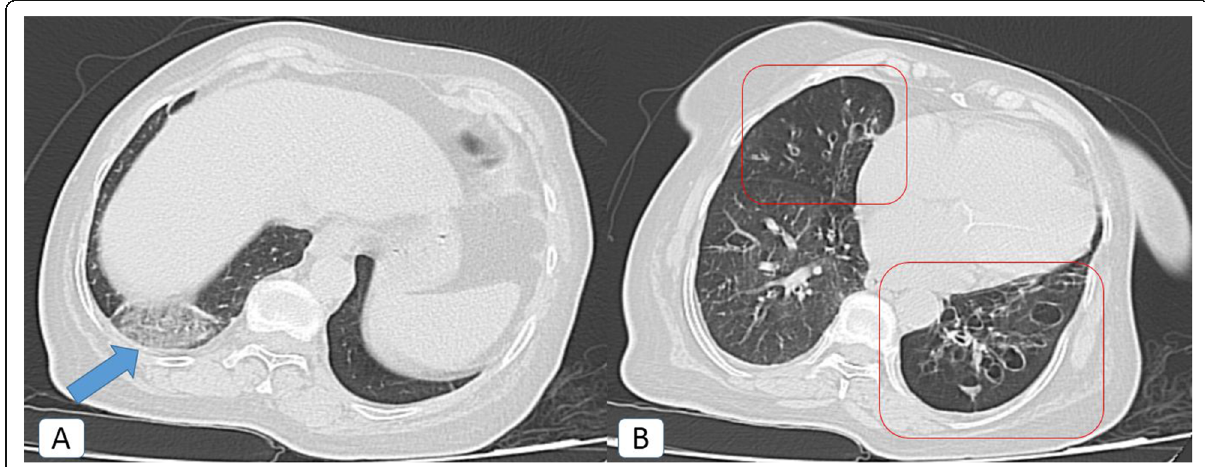
Fig. 8 COVID-19 infection atypically presented by cystic bronchiectasis: a 58-year-old female COVID-19 patient without a history of previous chest disease. A Axial chest CT (lung window) showing right basal sub-pleural ground glass patch (blue arrow). B Axial chest CT (lung window) showing right middle lobar traction bronchiectatic changes and left lower lobar cystic bronchiectatic changes with air-fluid levelling and air trapping (red